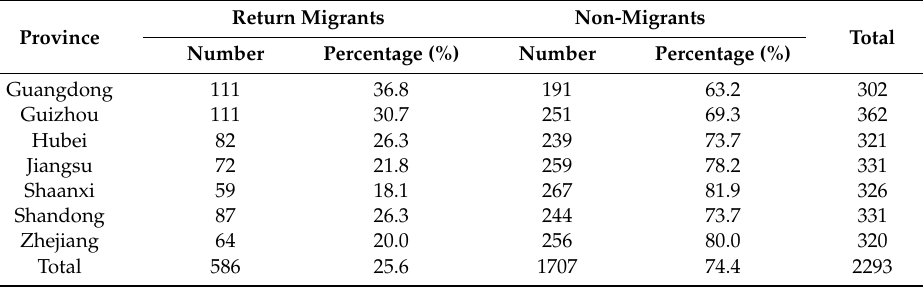
Figure 1. Location of the sample provinces and counties. Table 1. Number of return migrants and non-migrants by province.